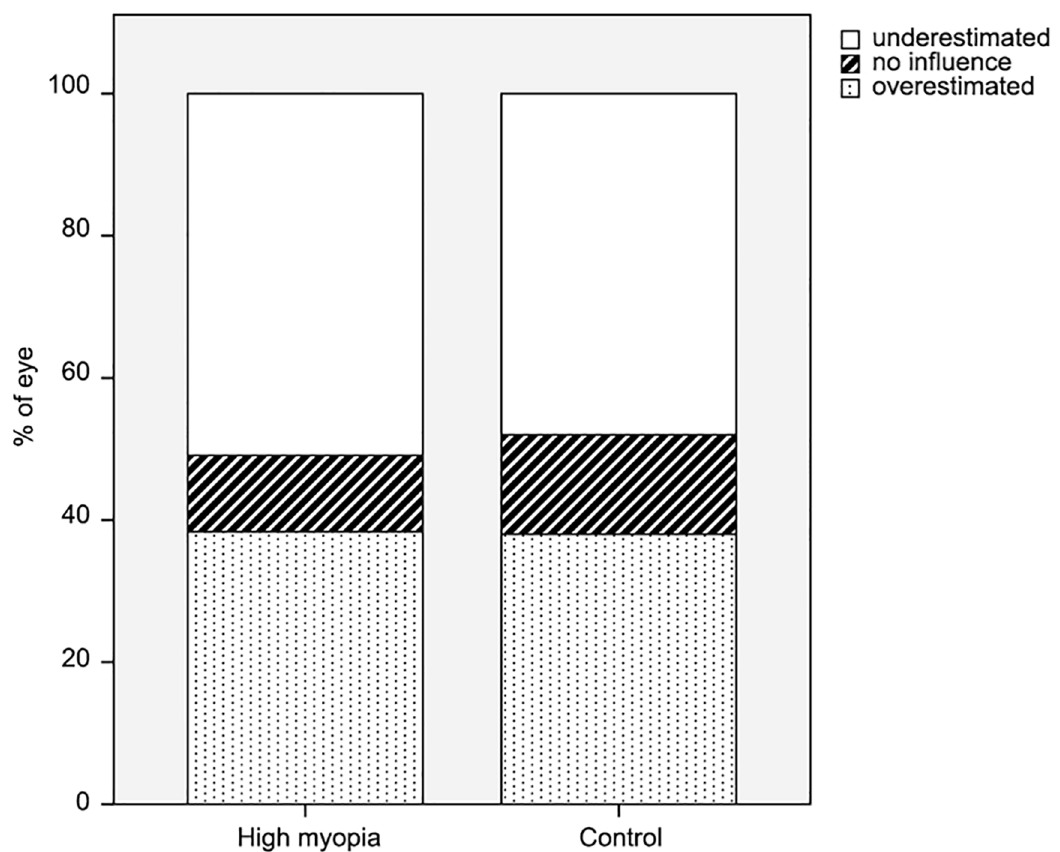
Fig 2. Estimation of total corneal astigmatism by anterior corneal measurement. No statistically significant difference in total corneal astigmatism was found between the high-myopia and control groups (p = 0.669).